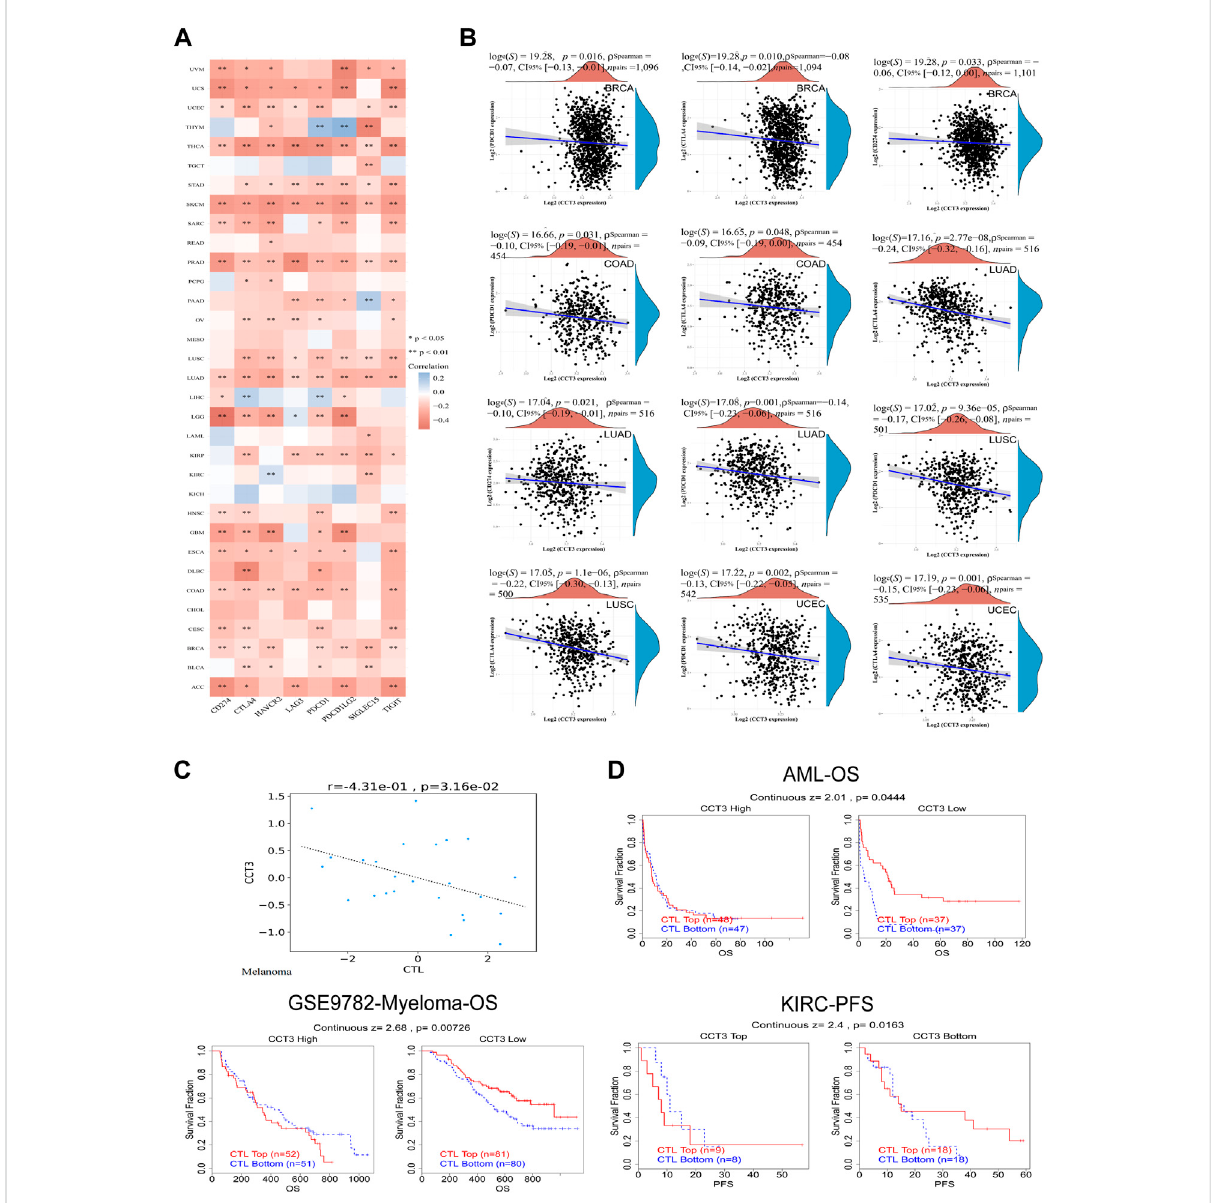
Correlation between CCT3 and immune checkpoint gene expression. (A) Heatmap showed the correlation between CCT3 and immune checkpointgeneexpressioninpan-cancer. (B) ThecorrelationbetweenCCT3andCD274, CTLA4andPDCD1expressioninACLBIdatabase. (C) The correlation between CCT3 and cytotoxic T lymphocyte (CTL). (D) The prognosis of tumor patients with different CCT3 expression and CTL levels. * p < 0.05, ** p < 0.01, *** p <